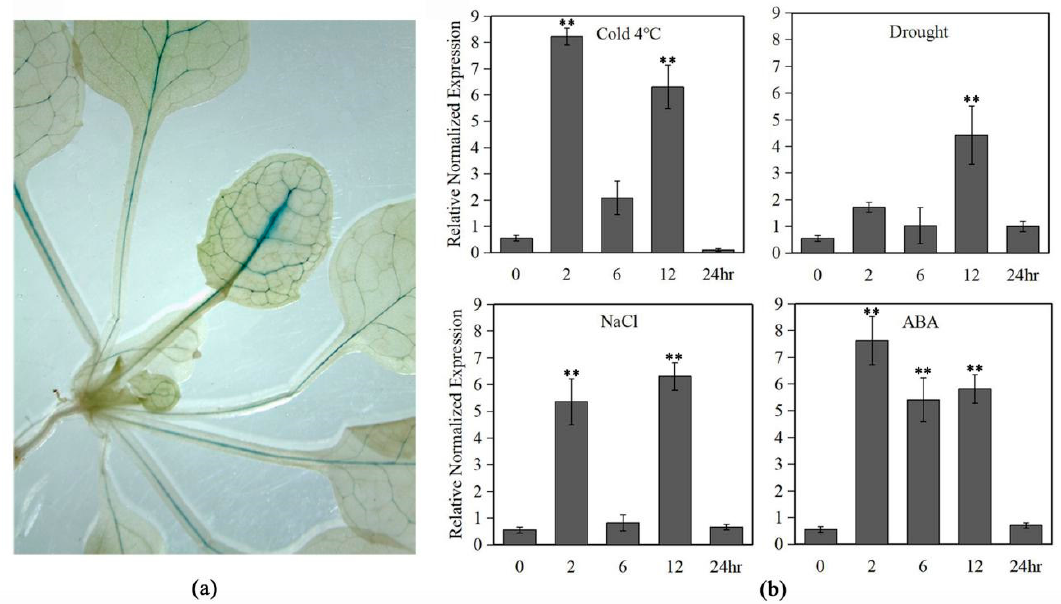
Figure 3. GUS activity of the LlMYB3 promoter in transgenic Arabidopsis plants. ( a ) Beta-glucuronidase (GUS) expression in untreated transgenic Arabidopsis plants. ( b ) The GUS transcript levels in the leaves of the transgenic Arabidopsis under cold (4 ◦ C), drought, salt and ABA treatments. The untreated transformants served as controls. There were 12 transgenic lines acquired. Values are means ± SD of three replicates. Three independent experiments were performed. Asterisks indicate a significant di ff erence (** p < 0.01) compared with the corresponding